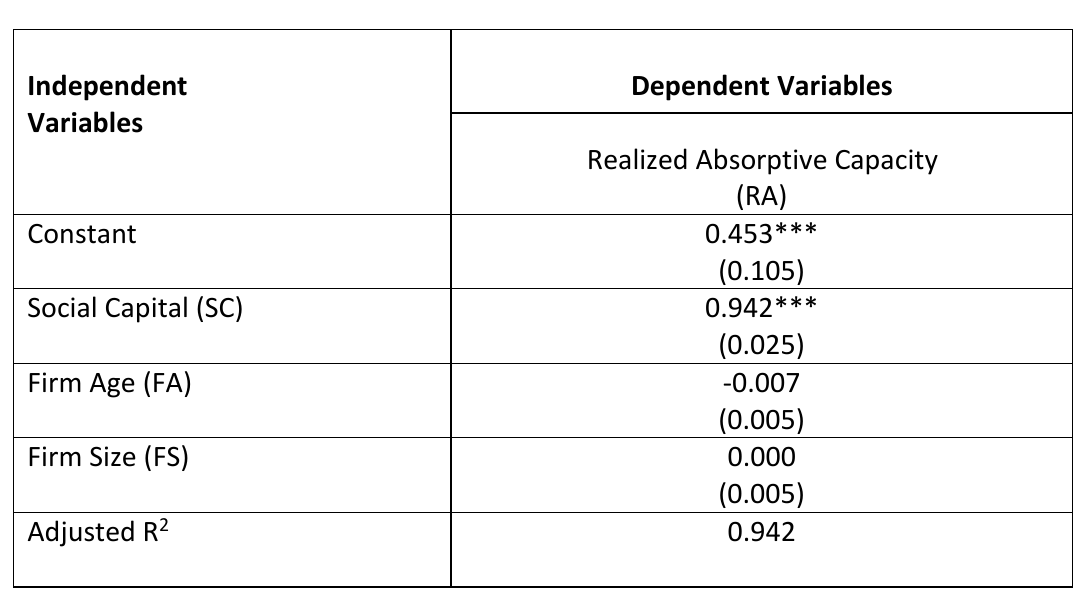
Table 4: Results of Regression Analysis.